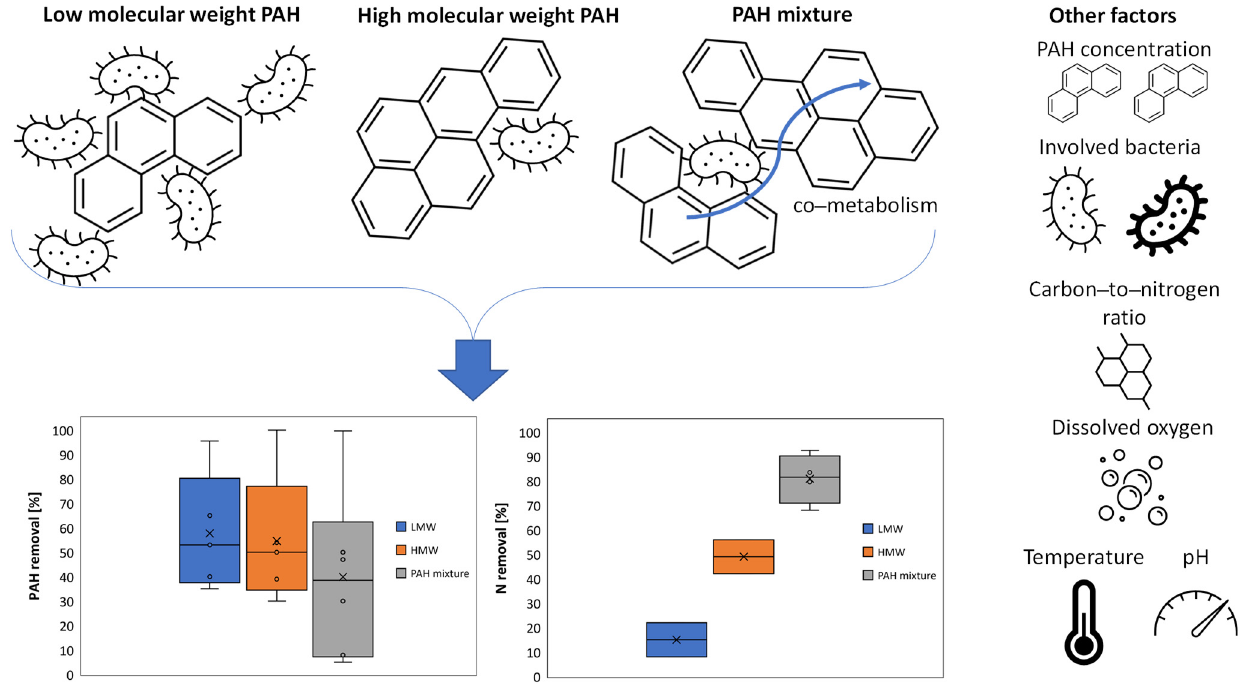
Figure 4. Factors affecting polycyclic aromatic hydrocarbon (PAH) degradation and total nitrogen (TN) removal. The middle lines and both ends in the boxes represent the medians and 25th and 75th percentiles of PAH and N removal. The lower and upper whiskers are the minimum and maximum values of PAH and N removal. The inner points display the data points that lie between the lower whisker line and the upper whisker line. The cross represents the mean marker of the selected series.